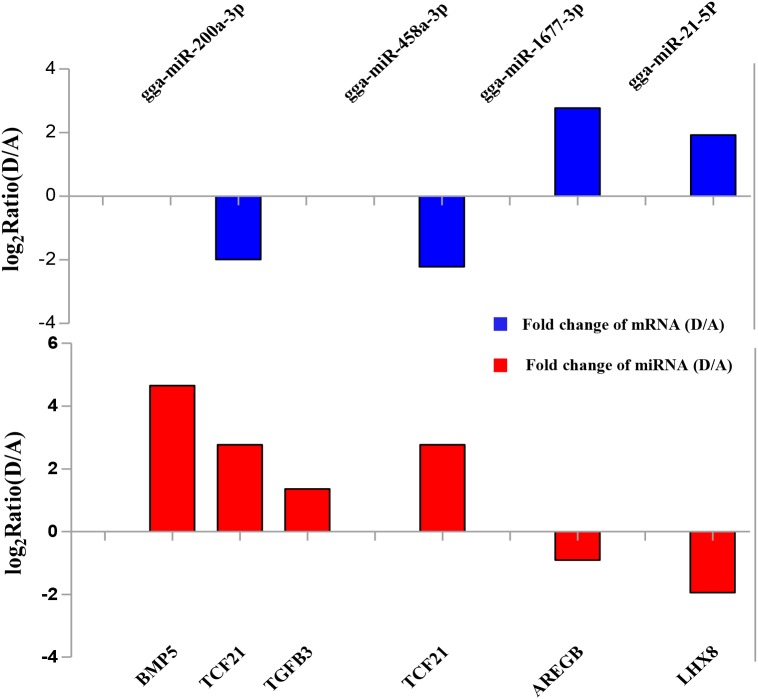
Verification of expression patterns of miRNA-mRNA interaction pairs by qRT-PCR.